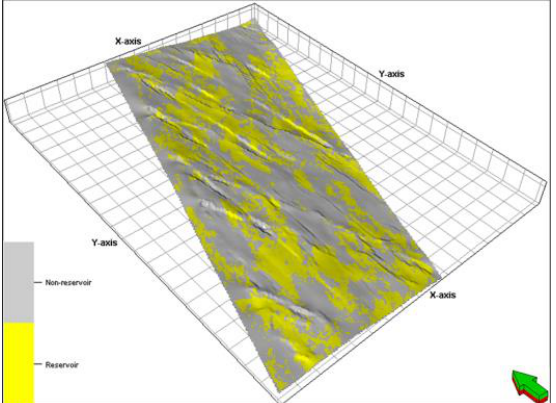
Figure 16. The porosity model of Unit 4 ( a ) and Unit 5 ( b ). The porosity model presents inverse variation trends in the units because it is constrained by the shale volume model. The porosity model of Unit 4 has a poor continuity in the south of the field, while it becomes more continuous in Unit 5.